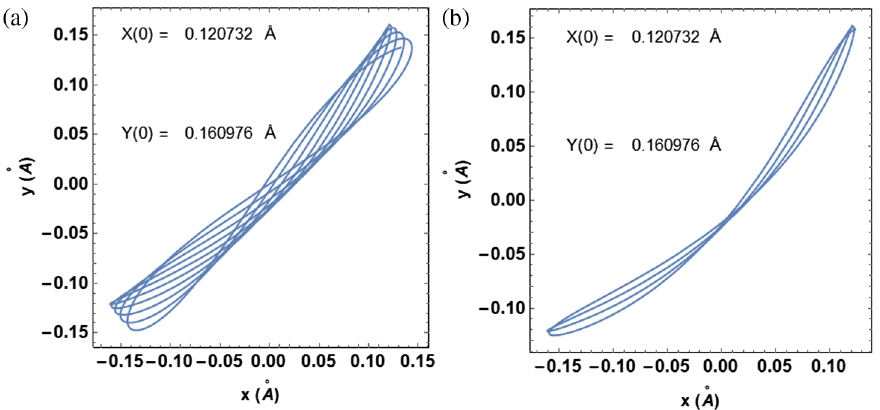
FIG. 2. Projected on the x − y -plane trajectories for 800 MeVelectrons axially channeled along the h 100 i axis of a W single crystal for parallel incidence at given coordinates x ð 0 Þ , y ð 0 Þ . (a) Five oscillation periods, (b) two oscillation